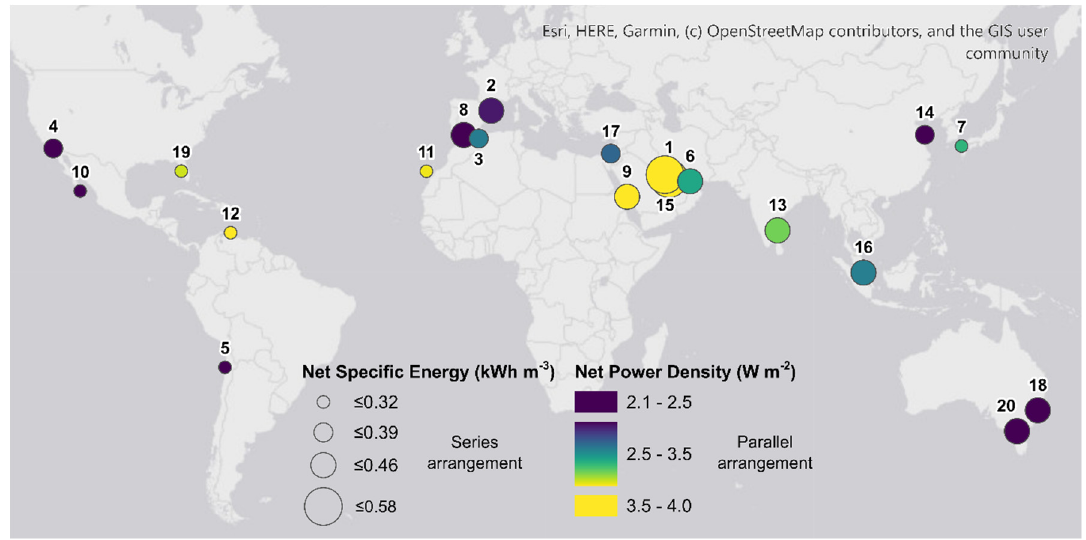
Figure 3. Performance of the RED system: Net Specific Energy—i.e., Net Energy per m 3 of desalted water, of the series-parallel network—and Net Power Density—i.e., Net Power per membrane pair active area, of the parallel arrangement. Series arrangement: seven industrial-scale RED units in series; number of parallel RED units set according to the total flowrate of SWRO’s brine available for conversion and the flowrate of concentrate stream fed to each RED unit.